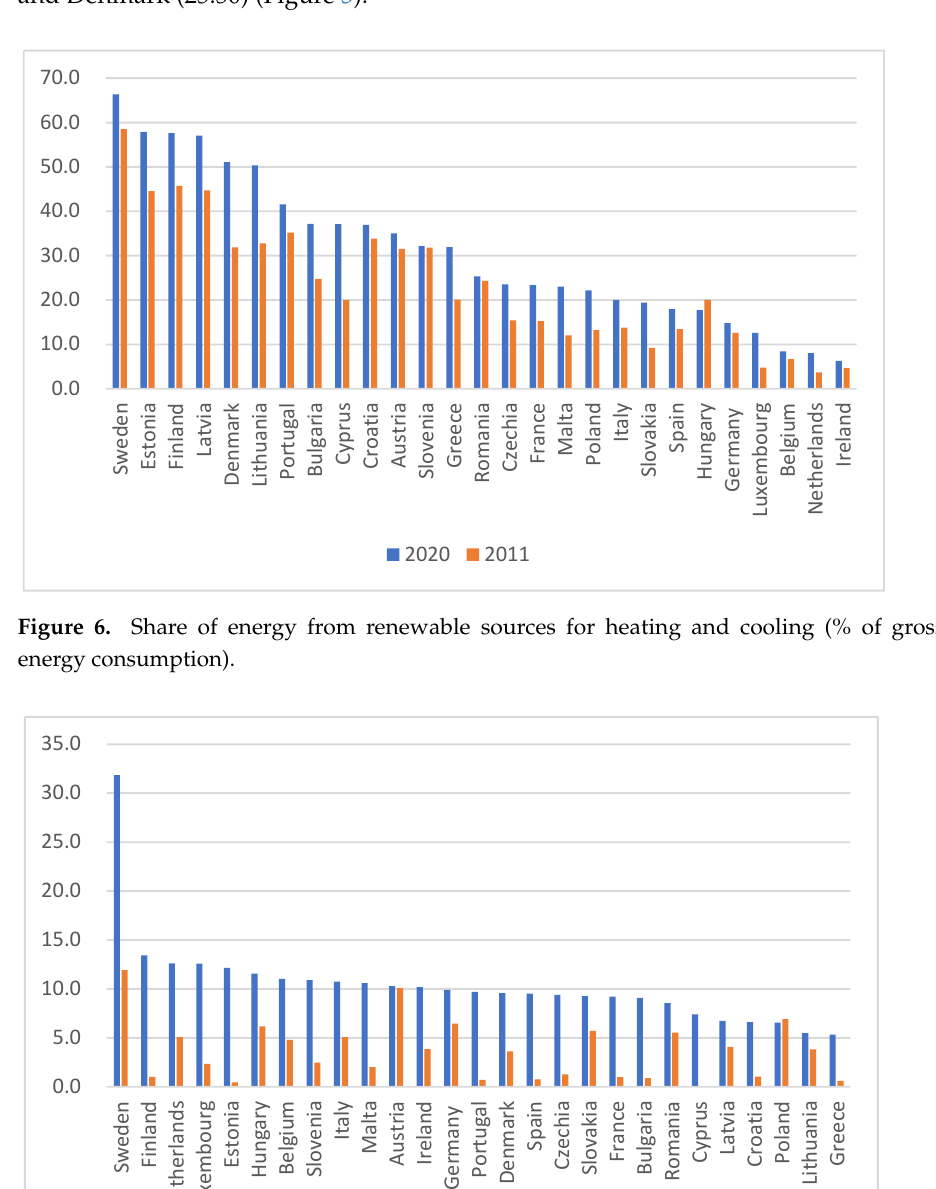
Figure 7. Share of energy from renewable sources in transport (% of gross final energy consumption).